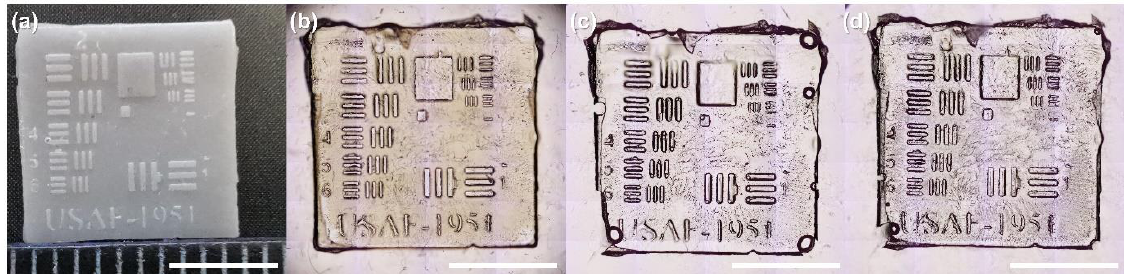
Figure 8. Results of μTM. ( a ) 3D printed 1951 USAF target (25% of the downloaded vector file size). ( b ) Soft PDMS mold. ( c ) and ( d ) are replicas made from C1 and C8 resins, respectively. Scale bars are the same in all the images and represent 5 mm.